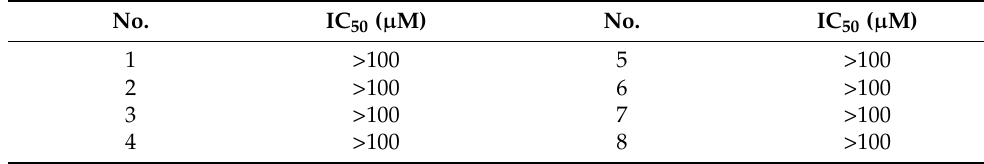
Table 3. Cytotoxic activities of compounds 1 – 8 .